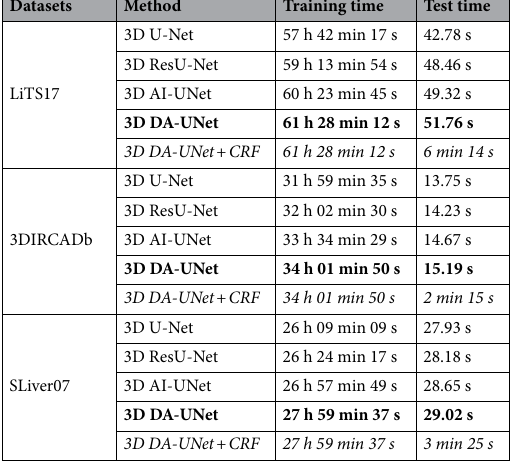
Table 3. Training and testing time-costs of various methods on three different datasets. Significant values are in bold and italics.